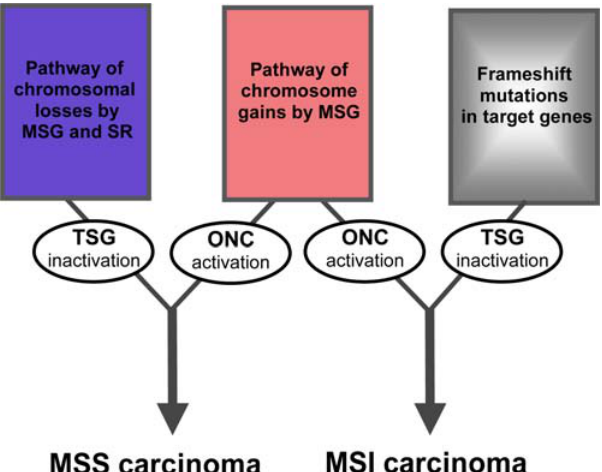
Figure 4. The role of chromosomal instability in near-diploid colorectal tumors according to MSI status. In MSS tumors, combination of the pathway of chromosome gains with that of chromosomal losses is necessary to target both oncogenes (ONC) and tumor suppressor genes (TSG), respectively. In MSI tumors, the pathway of chromosome gains is frequently observed whereas that of chromosomal losses is rarely found. In these tumors however, loss of function events are frequently observed as the consequence of frameshift mutations in coding microsatellite sequences. MSG, misse- gregation; SR, structural rearrangements.